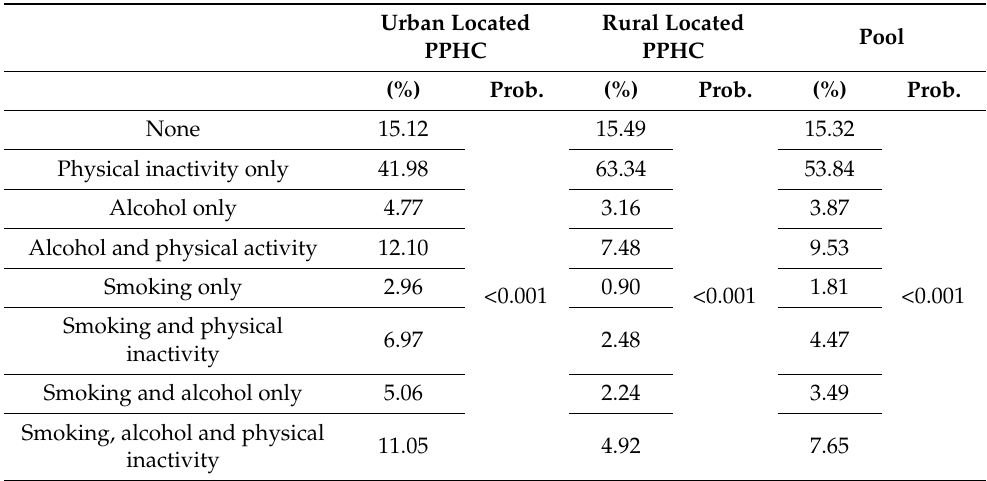
Table 4. Distribution of lifestyle risk factors by geographical location of Utilized Public Primary Healthcare Service (PPHC)